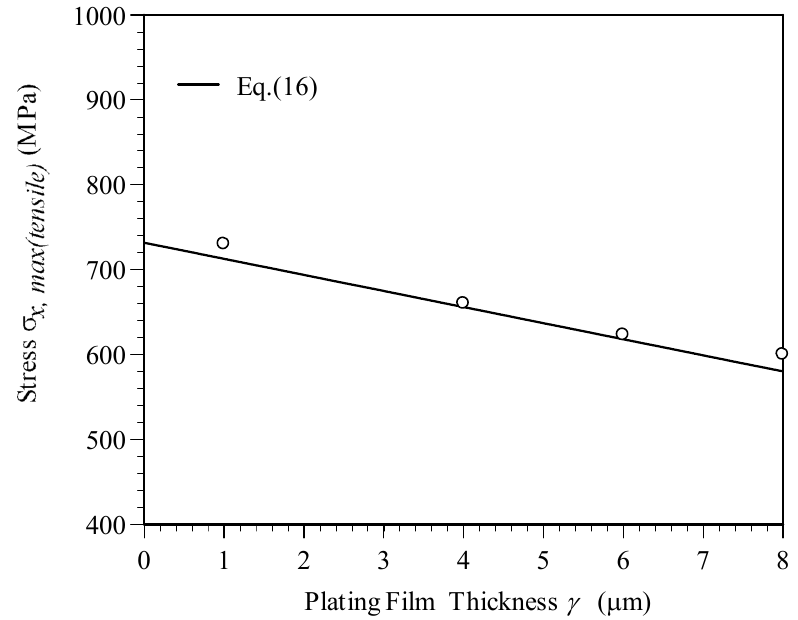
Figure 4. Variation of maximum tensile bending stress σ at fixed end for various plating film thicknesses. x,max(tensile )